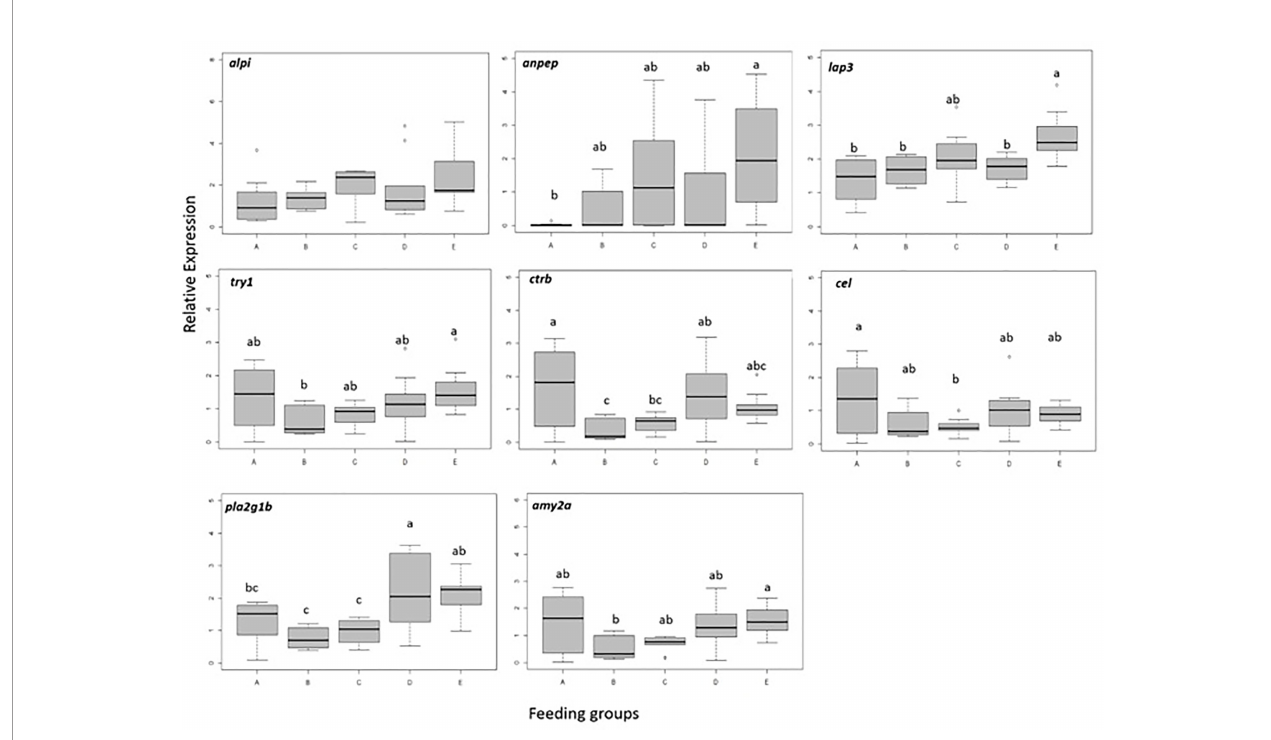
FIGURE 2 | Relative expression of genes in pikeperch larvae at the end of experimental period (17 DPH) at different feeding regimes ( n =10 larvae per group). Different letters denote signi fi cant ( p <0.05) differences among feeding groups. Box limits correspond to upper and lower quartiles, whiskers to minimum and maximum values, horizontal bar to the median, and points show outliers outside the 1.5 times interquartile